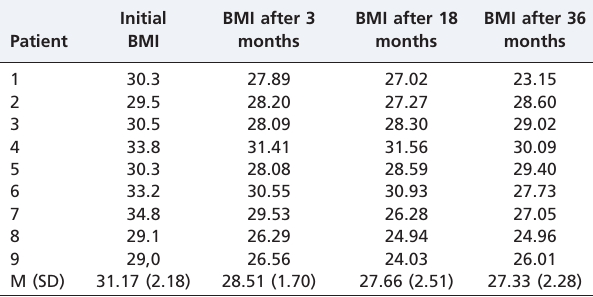
Table 1 - Comparison of BMI between the